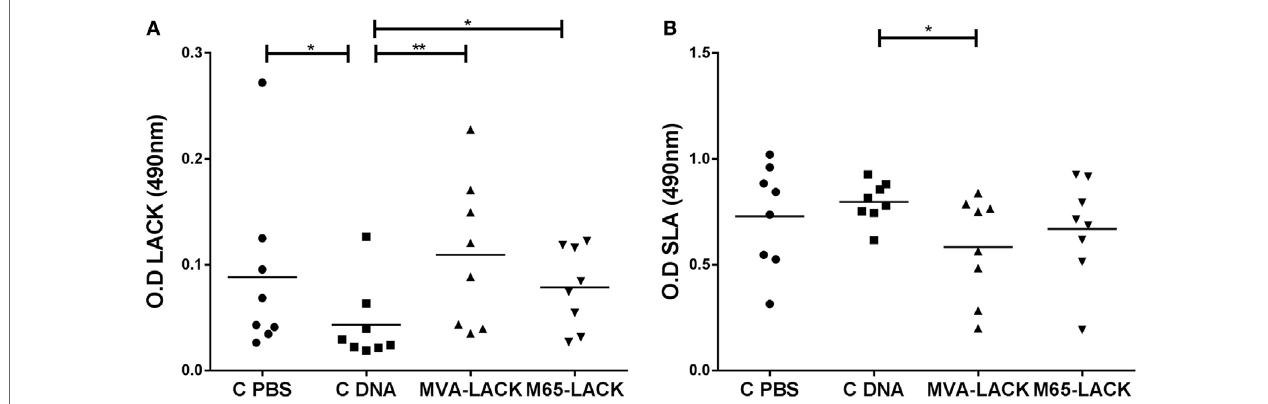
FigUre 2 | IgG levels against Leishmania -activated C-kinase antigen (LACK) (a) and soluble Leishmania antigen (SLA) (B) in the plasma of prime-boost immunized, C-DNA, and C-PBS group hamsters later infected with Leshmania. infantum . * p ≤ 0.05, ** p ≤ 0.01.